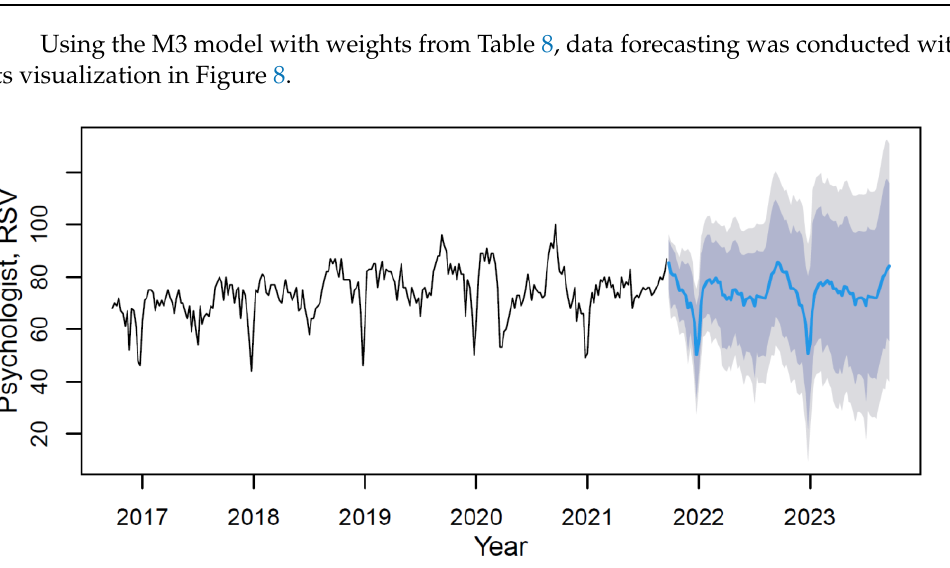
Figure 8. The psychologist’s data time series plot ( solid black line) with forecast (solid blue line) on light grey (95% CI) and dark grey (80% CI) backgrounds) by applying the M3 hybrid model.